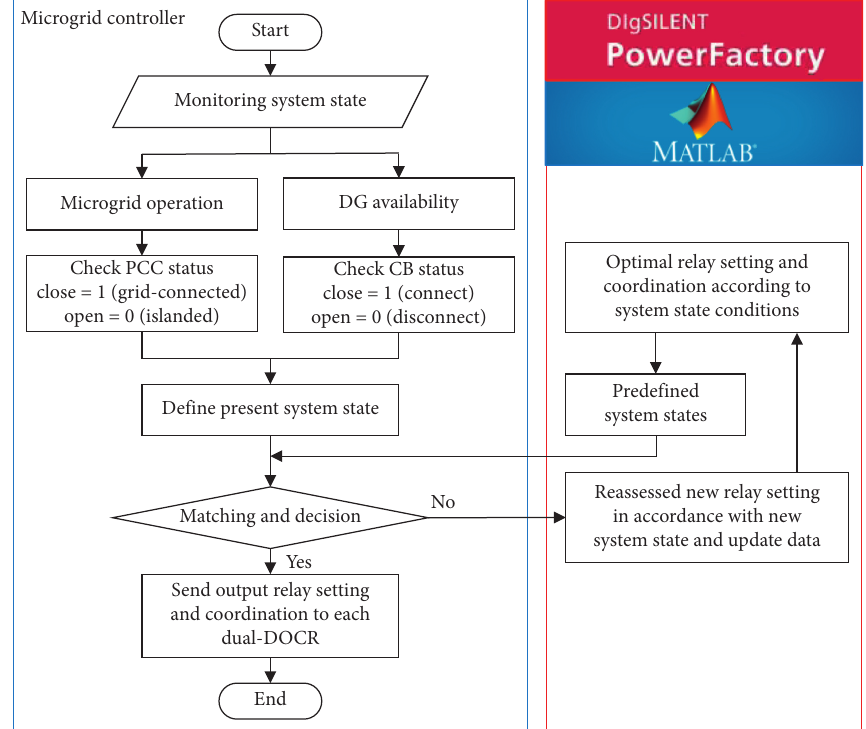
Figure 7: Protection system control